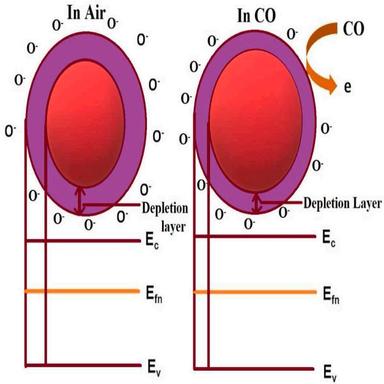
The schematic representation of the C.O. sensing mechanism.